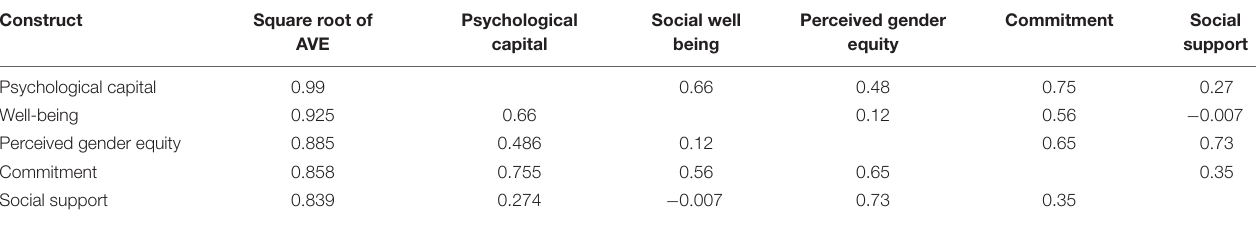
TABLE 4B | Comparison of square root of average variance extracted (AVE) and inter-construct correlations. Construct Square root of